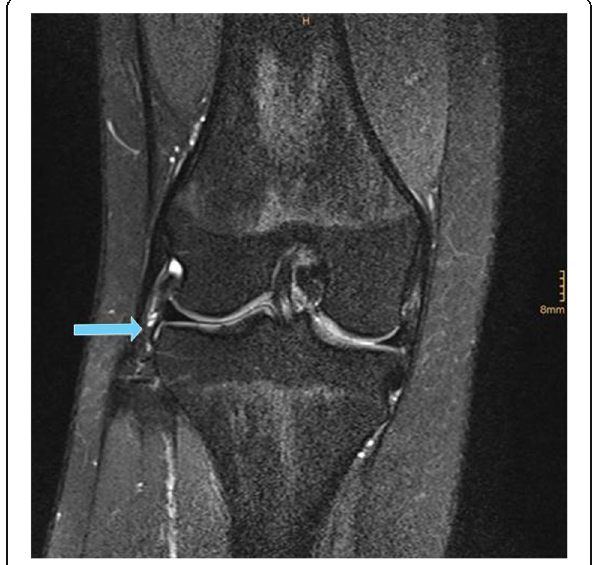
Fig. 1 Tibial part (blue arrow) of the anterolateral ligament (ALL) as seen in 73.2% of the examined cases (coronal PD-weighted sequence with fat